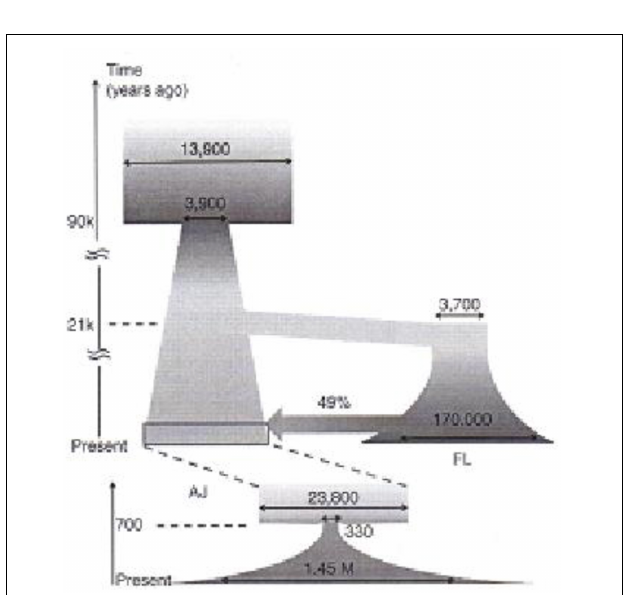
FIGURE 6 | Reconstruction of the Ashkenazi Jewish (AJ) and European (FL) demographic history. The wide arrow represents an admixture event. Horizontal arrows: effective population sizes (Carmi et al.,